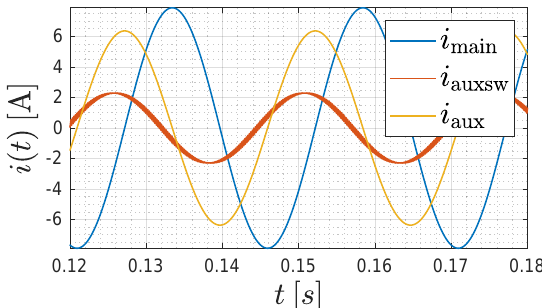
Figure 7. The method of conservation of energy for current phase advancing.